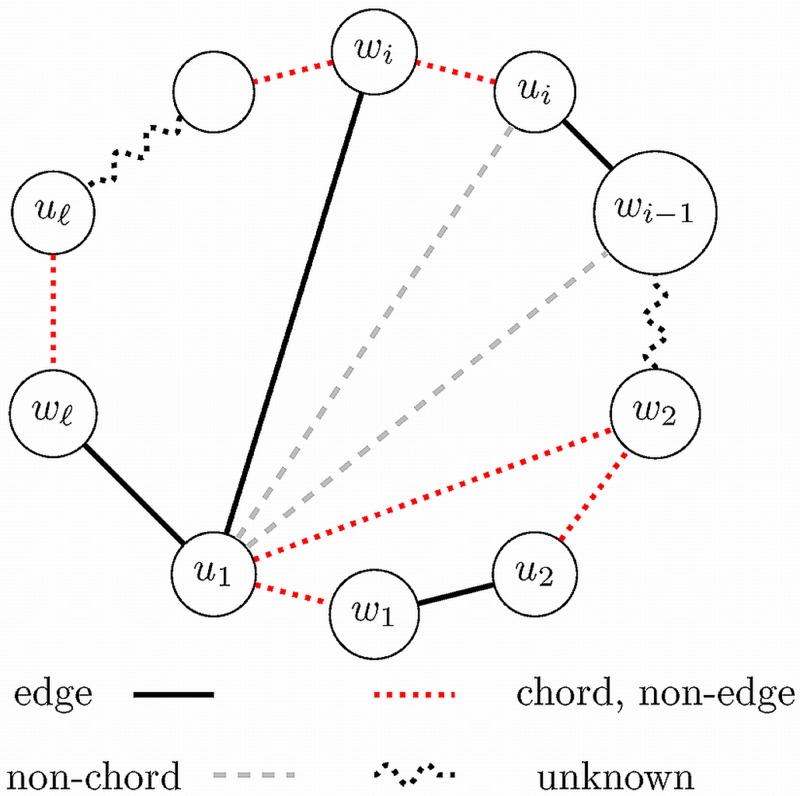
Sweeping a cycle.